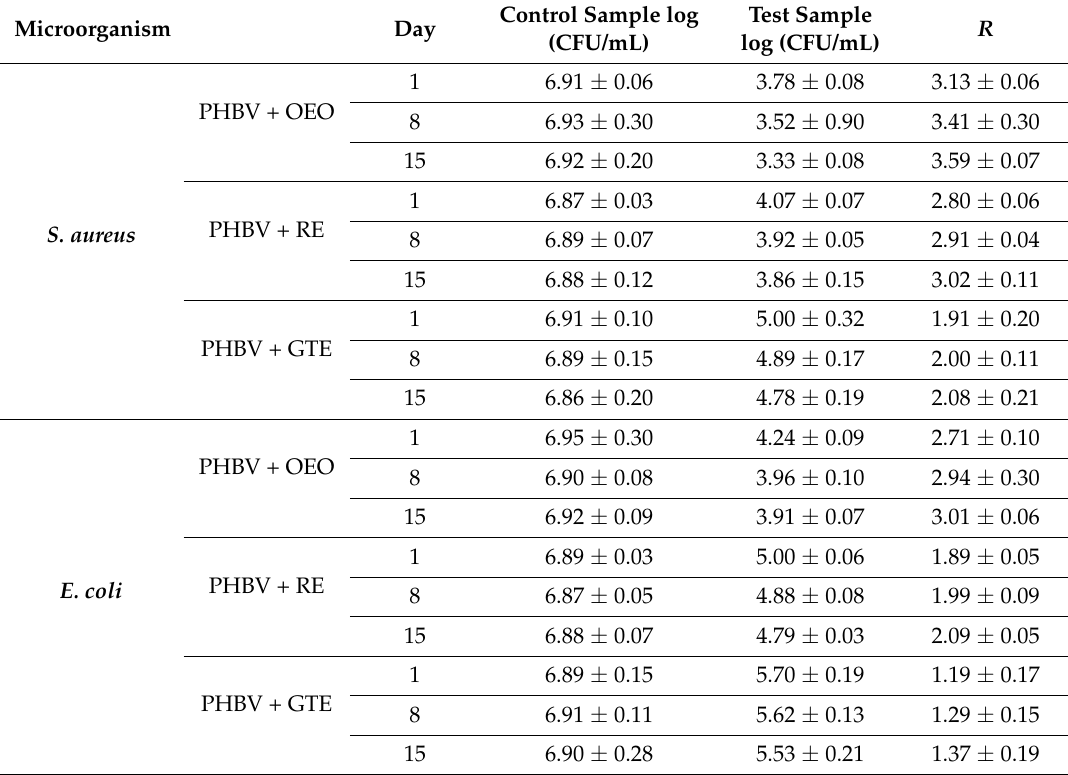
Table 6. Antibacterial activity against S. aureus and E. coli of the electrospun poly(3-hydroxybutyrate- co -3-hydroxyvalerate) (PHBV) films containing oregano essential oil (OEO), rosemary extract (RE), and green tea tree extract (GTE) in the closed system for up to 15